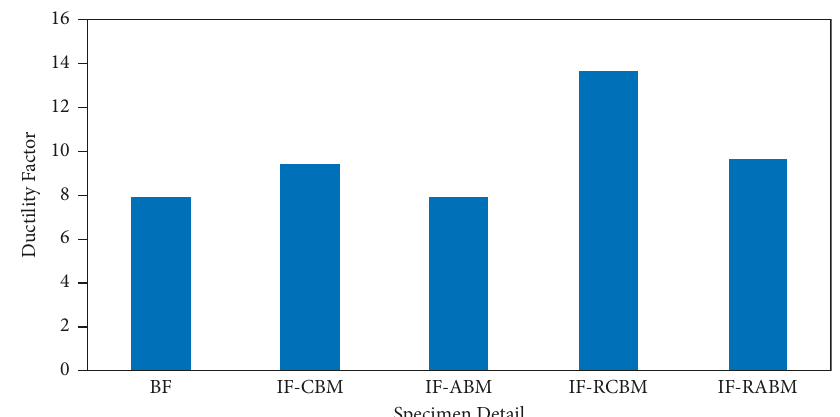
Figure 8: Ductility of specimen.